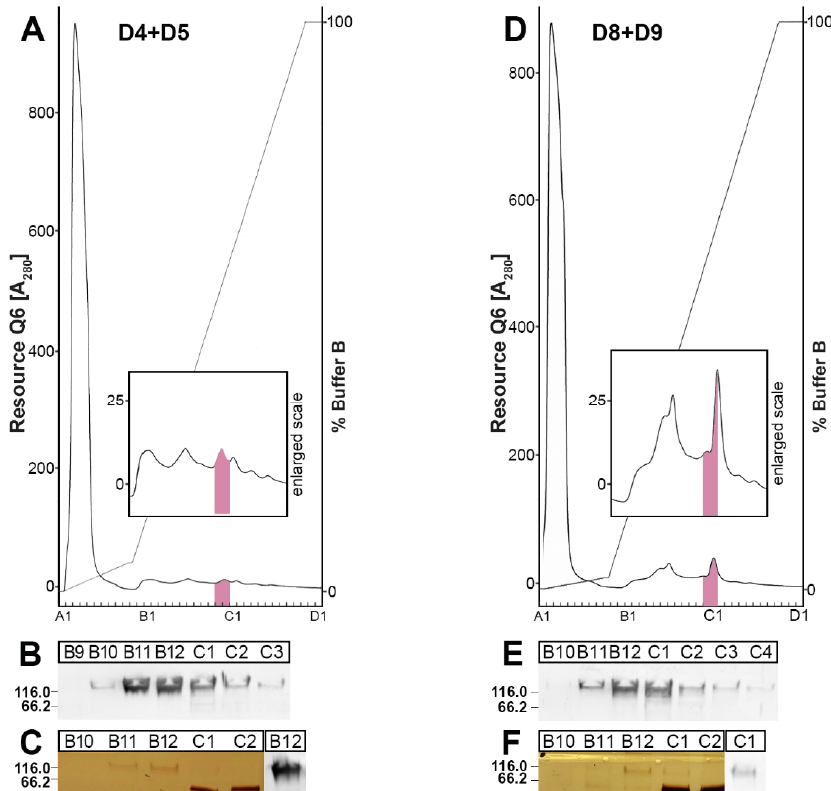
Figure 4. Purification of X. laevis FIM-A.1 by SEC and anion-exchange chromatography. ( A ) Fractions D4 + D5 (1 mL each) from the SEC of Figure 2 were separated by anion-exchange chromatography on Resource Q6. Elution profile as determined by absorbance at 280 nm (PAS-positive mucin fractions: pink). ( B ) 15% SDS-PAGE of fractions B9–C3 under reducing conditions and Western blot analysis using anti-FIMA-1. ( C ) 15% SDS-PAGE of fractions B9–C2 under non-reducing conditions and silver staining. For comparison, Western blot analysis of fraction C1 using anti-FIMA-1. ( D ) Separation of fractions D8 + D9 analogous as described in ( A ). ( E ) Western blot analysis of fractions B10–C4 using anti-FIMA-1. ( F ) Silver staining of fractions B10–C1 and Western blot analysis of fraction C1 using anti-FIMA-1.